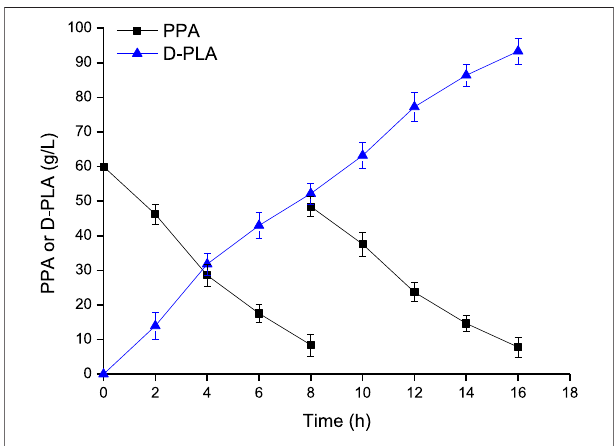
FIGURE 6 | D-PLA production by whole-cell bioconversion using the CP303 strain in a 5 L bioreactor. Data are means ± SD ( n (cid:1) 3).